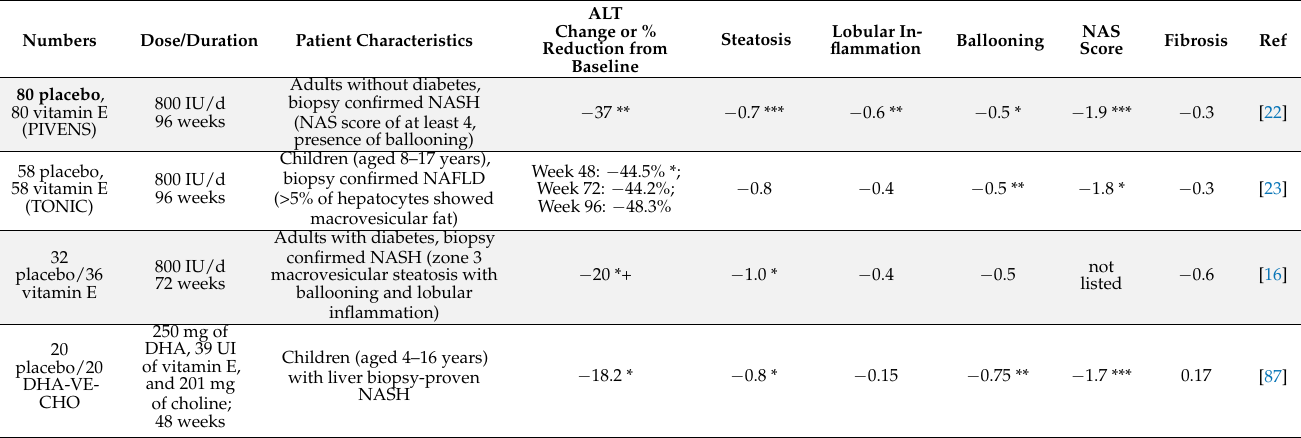
Table A1. Changes in mean score or ALT value from baseline in the vitamin E treatment group. Statistical significance for the comparison vitamin E treatment to placebo: * p < 0.05, ** p < 0.01, *** p < 0.001, + graphically